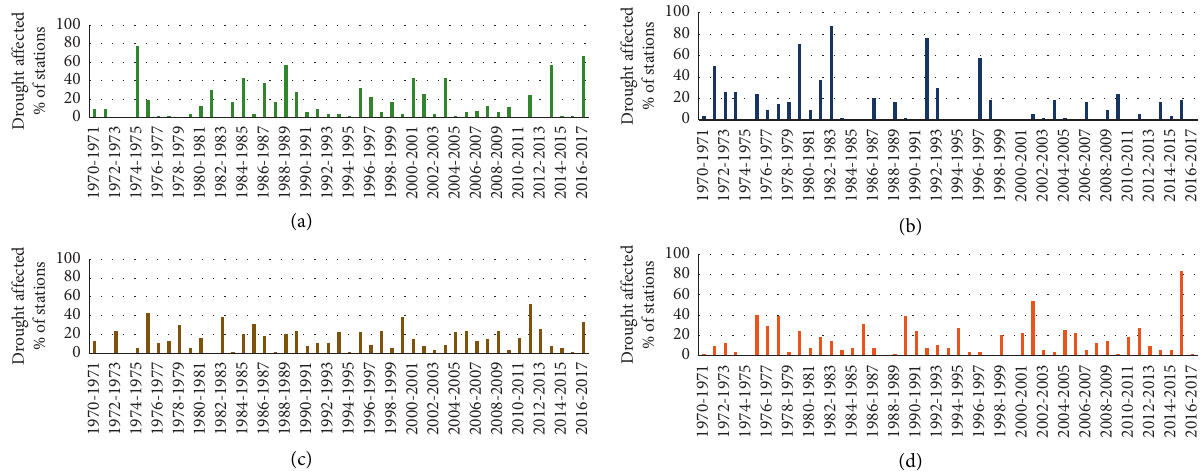
Figure 4: Percentage of stations showing drought events in SPI (d) July–September.